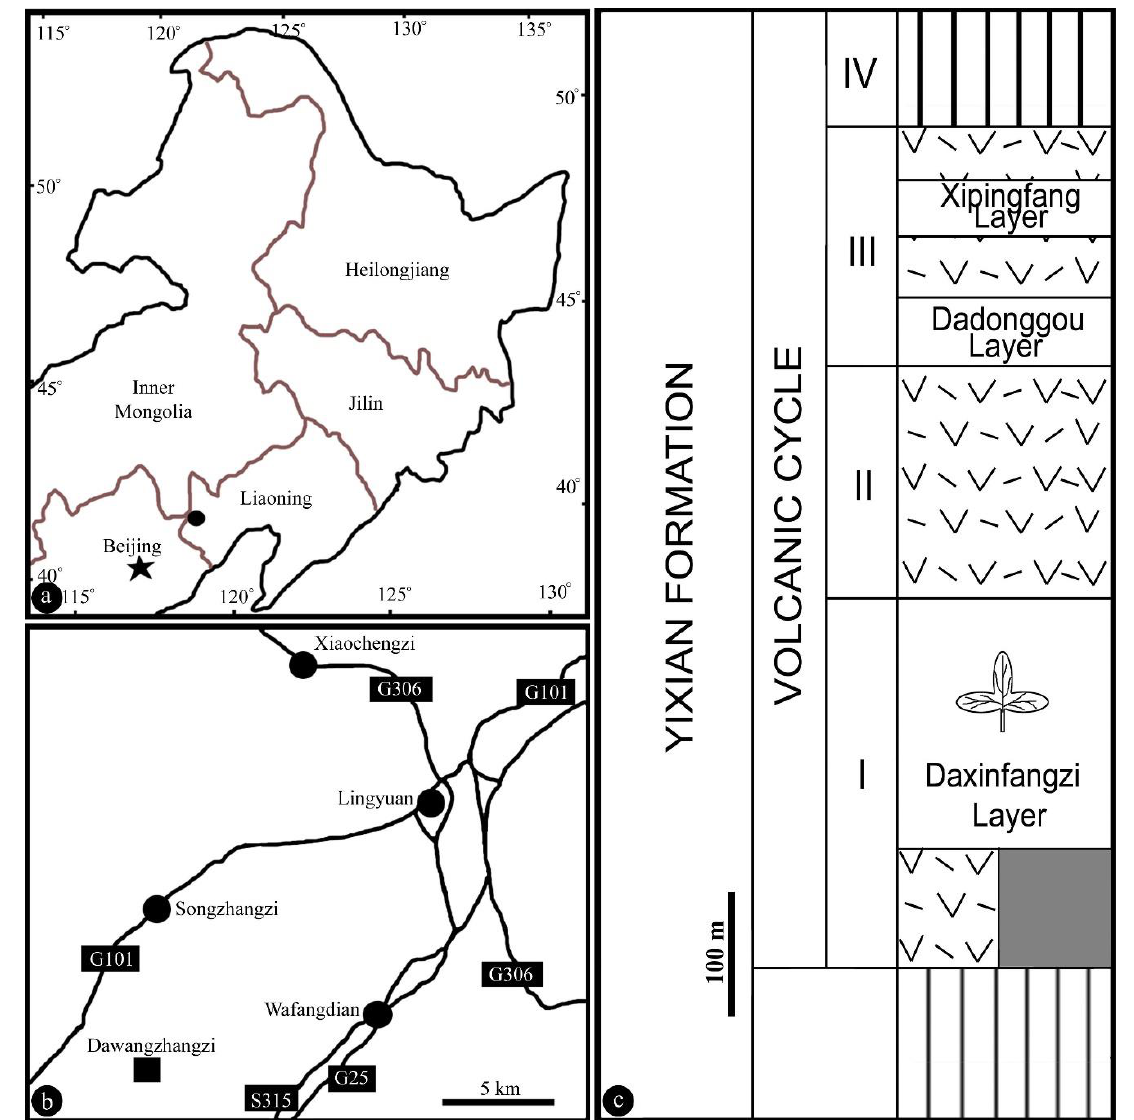
Figure 1. Geographical position of the fossil locality of Lingyuananthus gen. nov. in western Liaoning, China. ( a , b ), Modified from Liu and Wang (2018); ( c ), modified from Wang et al. (2021). ( a ) Fossil locality (black dot) in northeastern China; ( b ) position of fossil locality (black square) in a suburb of the city Lingyuan, Liaoning; ( c ) stratigraphic column of the Yixian Formation yielding the specimen. The column includes various volcanic eruptions and intercalating siltstones. The specimen was uncovered from the Daxinfangzi Layer.